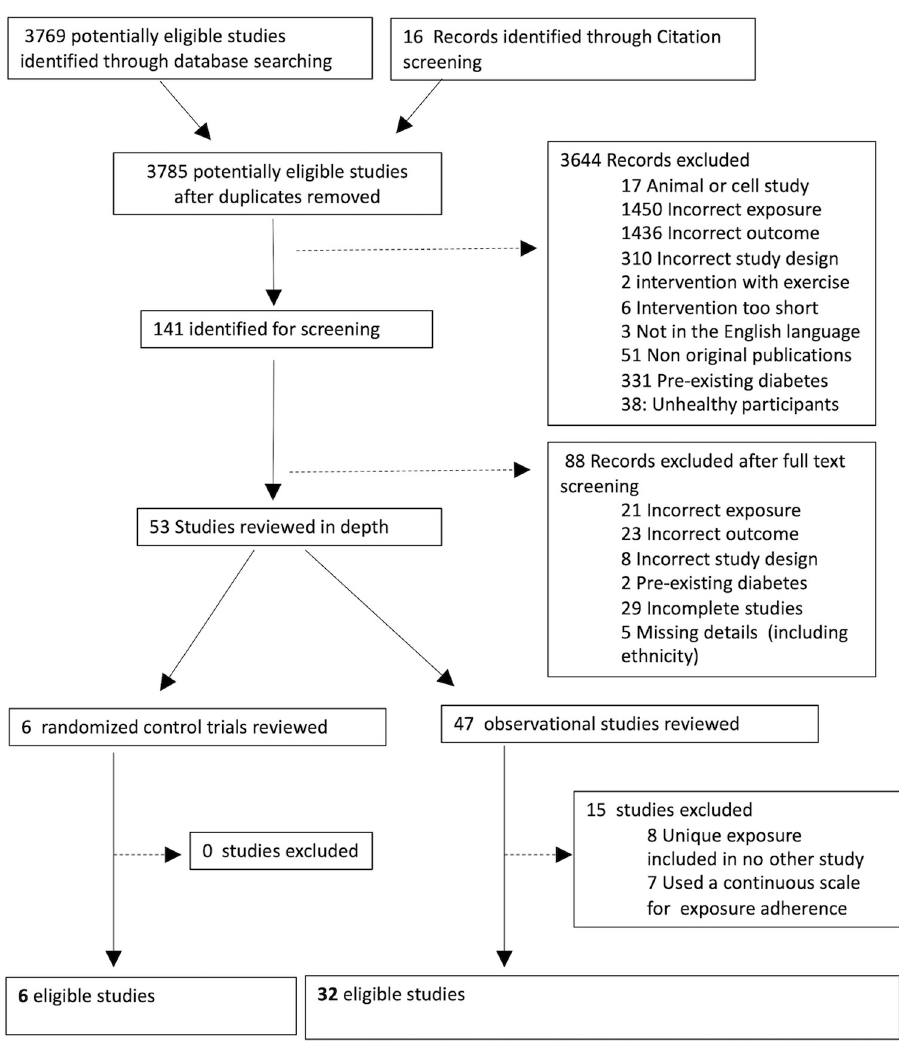
Fig 1. Prisma diagram. Outline of identification of studies in Ovid (AMID, CAB abstracts, EBM, EMBASE, Global Health, Health Care Management Information Consortium, MIDRIS, OVID Medline R), Cochrane (including trial registries), Scopus, and PubMed and record of screening process of